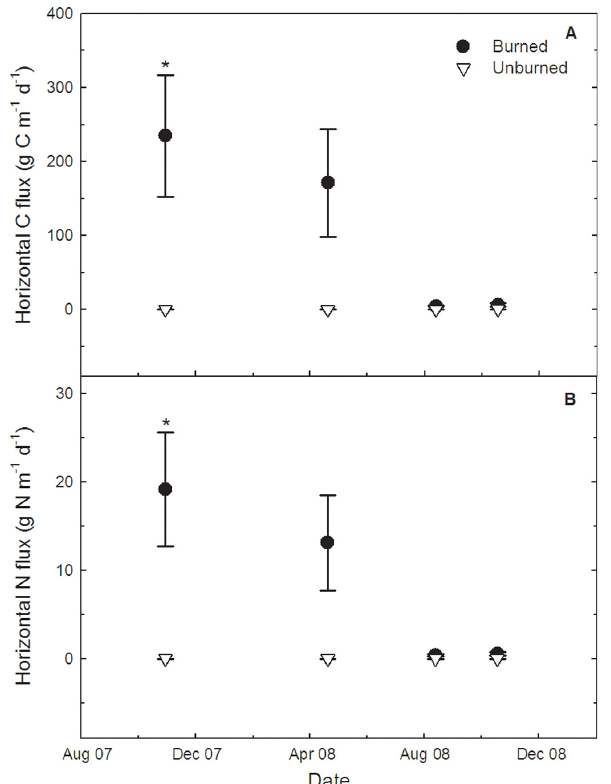
Fig. 3. Mean ( ± SE) horizontal fluxes of carbon (A) and nitro- gen (B) in the burned (filled circles) and unburned (open triangles) area. Horizontal fluxes of C and N were calculated by multiply- ing nutrient concentrations (g C or N kg − 1 sediment) by sediment discharge rates (kg sediment m − 1 d − 1 ) for each size class and sam- pling date (* denotes significant site differences at P < 0 .